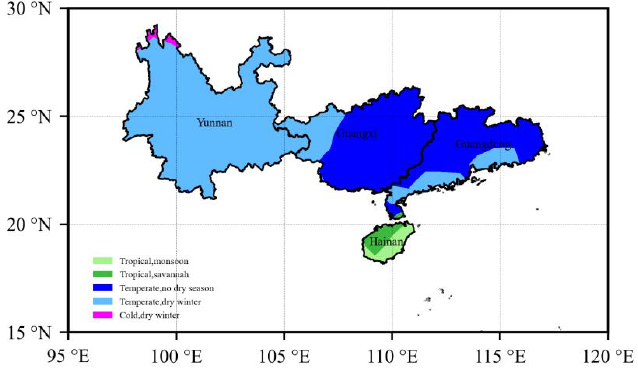
Figure 1. Climate zones according to Köppen–Geiger climate classification in the study area.